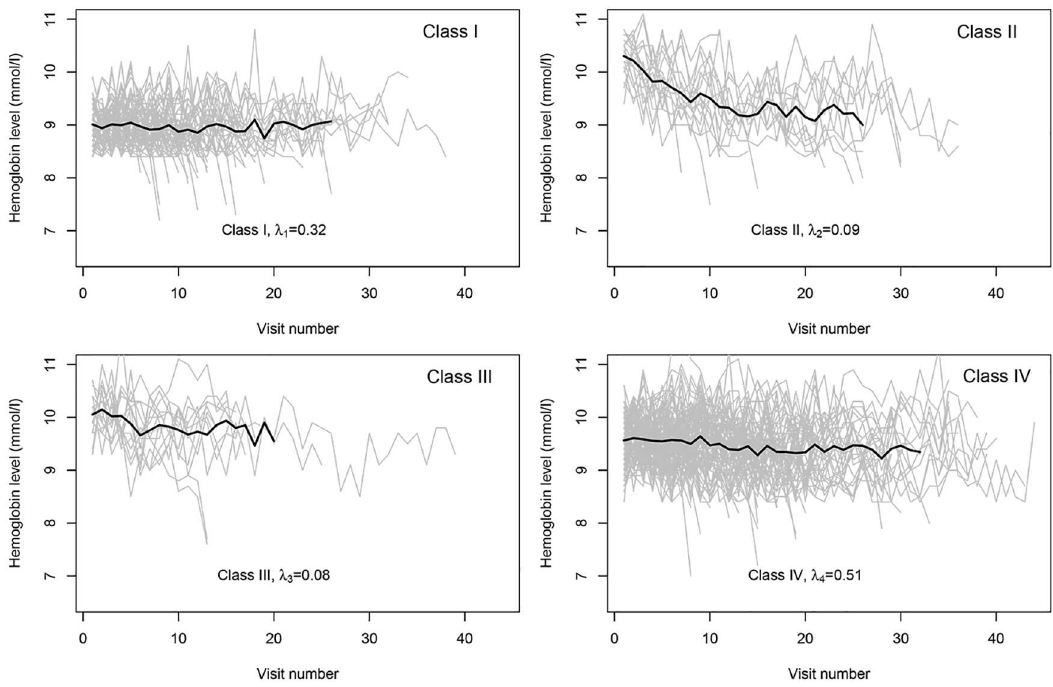
Fig 3. Hb profiles for four different classes.